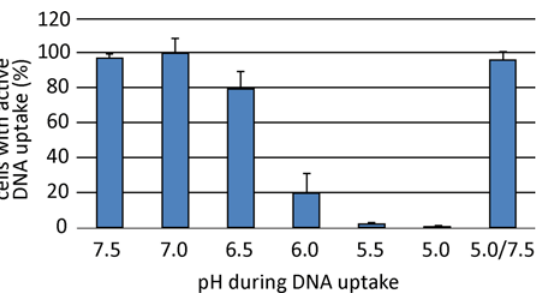
Fig 3. DNA uptake complexes are reversibly shut down at acidic pH values. Competent bacteria were incubated in BB-FBS that had been titrated with HCl or NaOH to the indicated pH values. Uptake of Cy3-labelled λ DNA occurred for 10 min under aerobic conditions. Cells were washed once in the respective pH medium before DNase treatment for 5 min in TSB-FBS at pH 7.5. The fraction of competent cells relative to the control condition incubated in TSB-FBS at pH 7.5 are depicted. Values stem from at least three experiments; error bars, standard